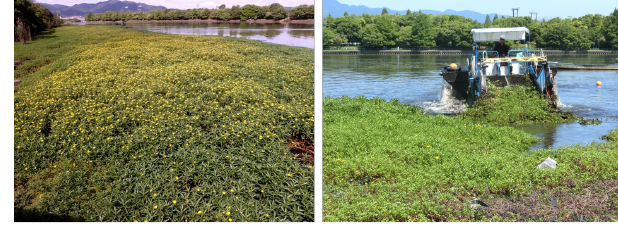
Fig. 2 . Ludwigia grandiflora in Lake Biwa, and its control. (Photos: Katsuki